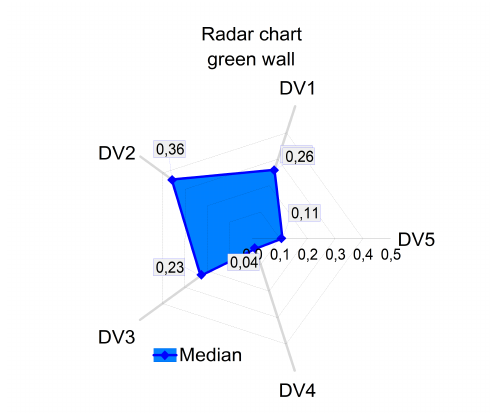
Figure 2: Radar chart for “green wall”. A 2 = 0,103